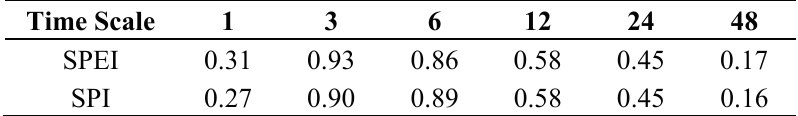
Table 7. Pearson’s R 2 correlation value of standardized runoff versus SPEI and SPI using one, three, six, 12, 24 and 48 month time scales over 1996 to 2005.